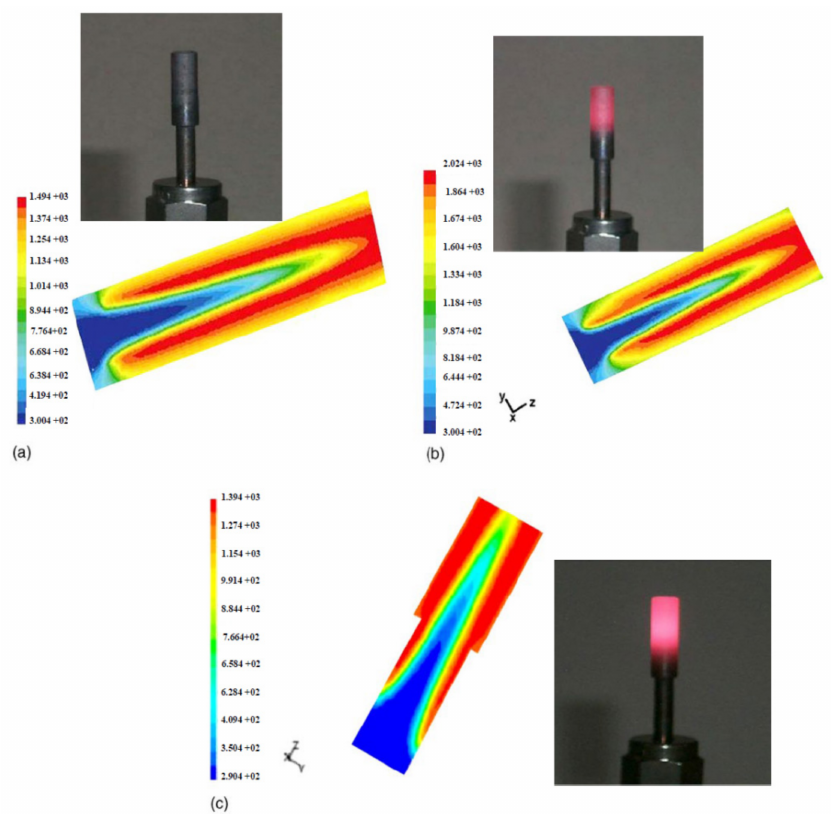
Figure 3. Combustion of the micro-combustor when the flow rate is 8 ms − 1 at different H 2 /air ratios ( σ = 0.45, 0.7, and 1.0) [41], ( a ) H 2 /air ratio is 0.45, ( b ) H 2 /air ratio is 0.7, ( c ) H 2 /air ratio is 1.0.